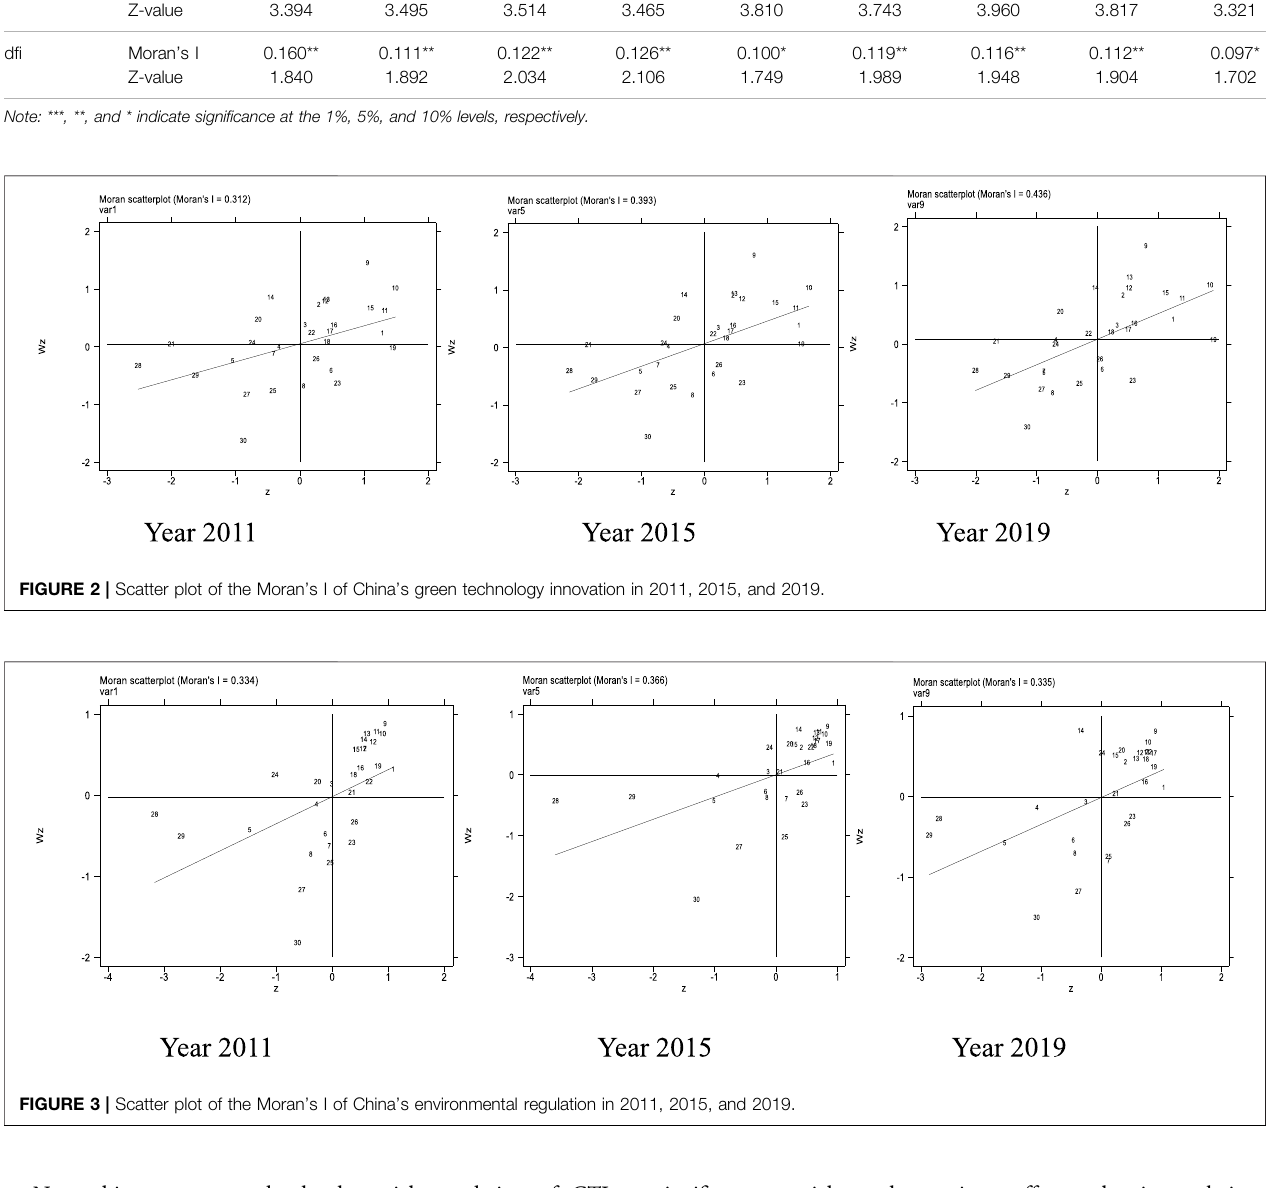
Frontiers in Environmental Science |